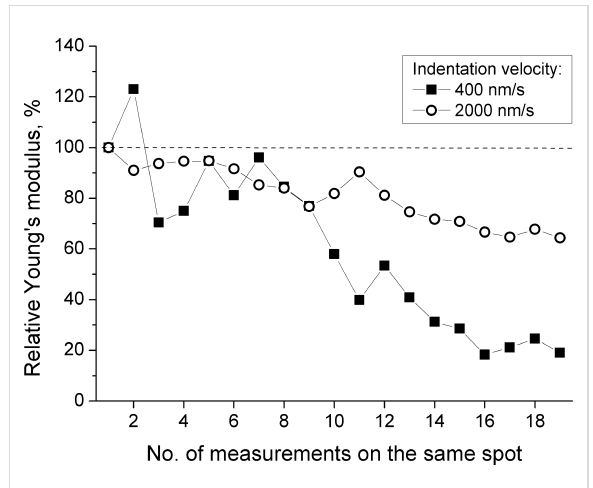
Figure 5: Relative percentage Young’s modulus E % for (PLL/HA) 72 as measured on one fixed spot. All the values are normalised to the E calculated from the first indentation. Indentation velocities are 400 nm/s (squares) and 2000 nm/s